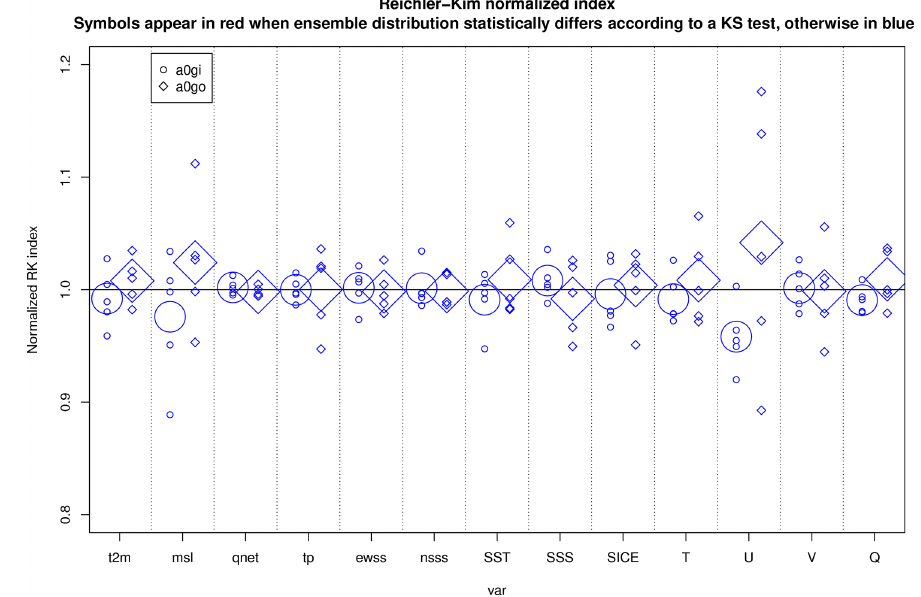
Figure 7. Same as Fig. 3 but for the pair of experiments carried out with EC-Earth 3.2, namely a0gi and a0go.